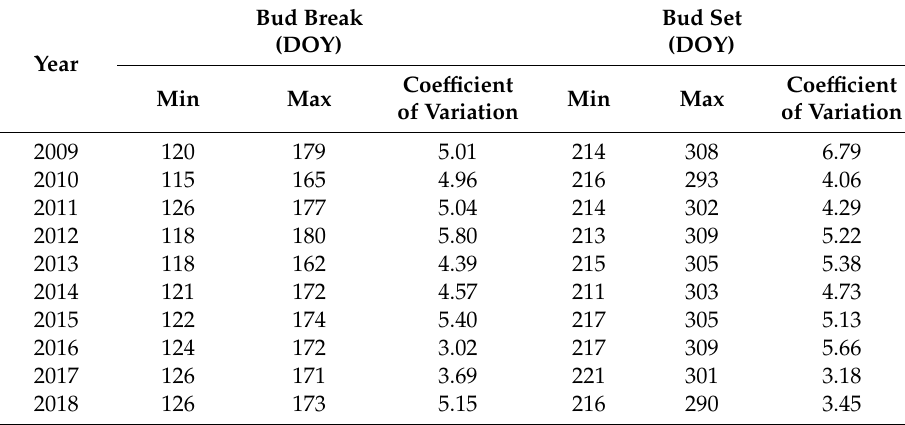
Table 2. Variability in bud phenology across the study